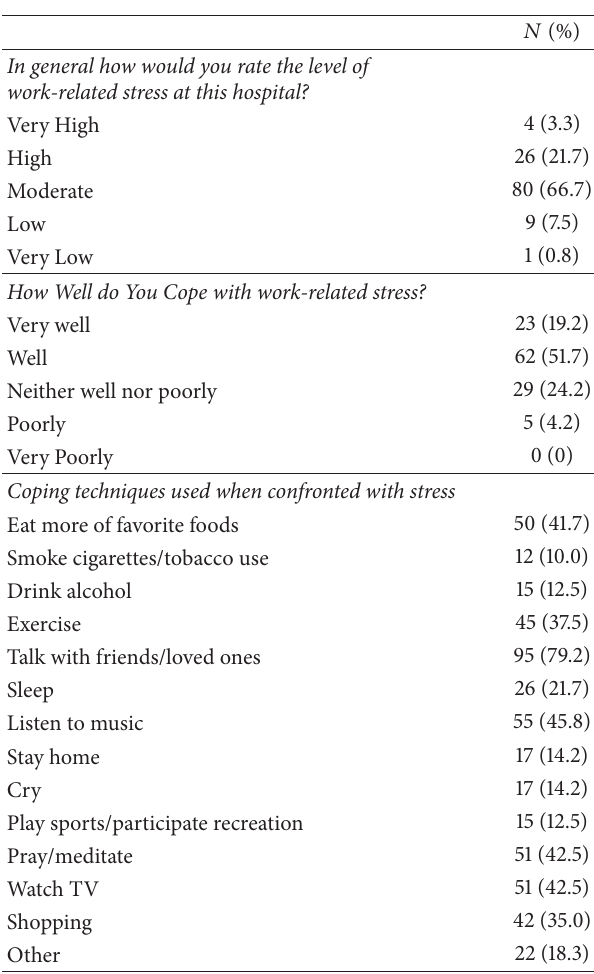
Table1:Perceptionsofwork-relatedstressandcopingabilityamong